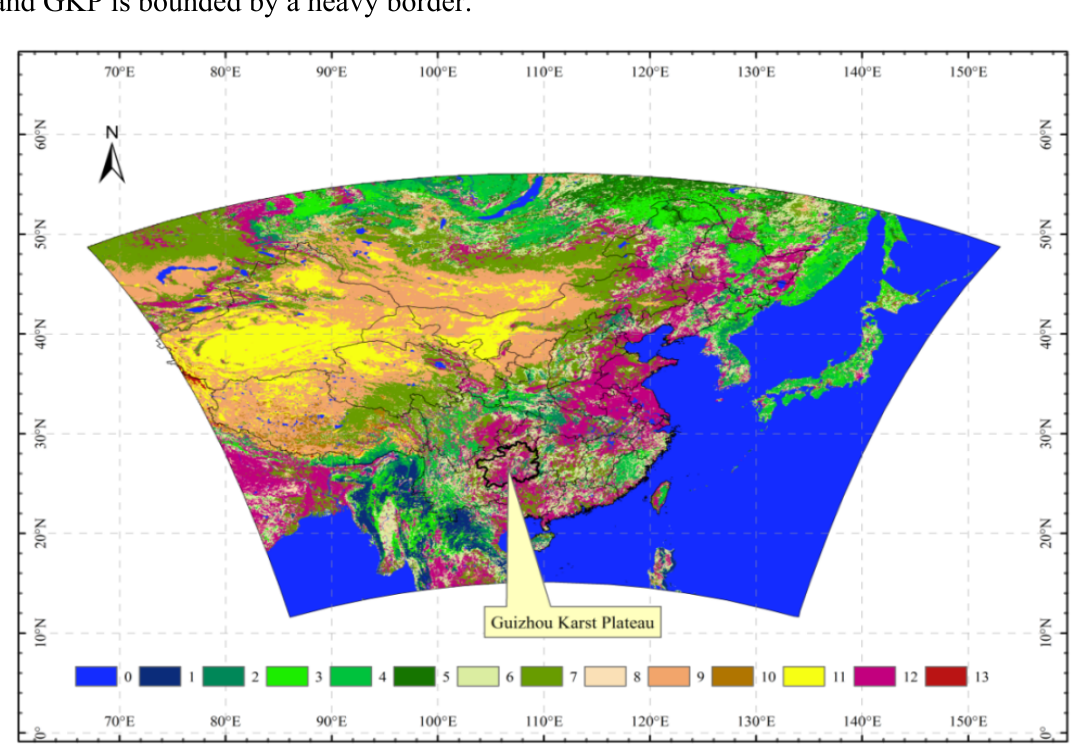
Figure 1. SSiB vegetation cover types. Type 0, water; Type 1, tropical rainforest; Type 2, broadleaf deciduous trees; Type 3, broadleaf and needleleaf trees; Type 4, needleleaf evergreen trees; Type 5, needleleaf deciduous trees; Type 6, broadleaf trees with ground cover; Type 7, grassland; Type 8, broadleaf shrubs with ground cover; Type 9, broadleaf shrubs with bare soil; Type 10, dwarf trees with ground cover; Type 11, bare soil; Type 12, crops; Type 13, permanent ice. The experimental domain is shaded and outlined in this figure, and GKP is bounded by a heavy